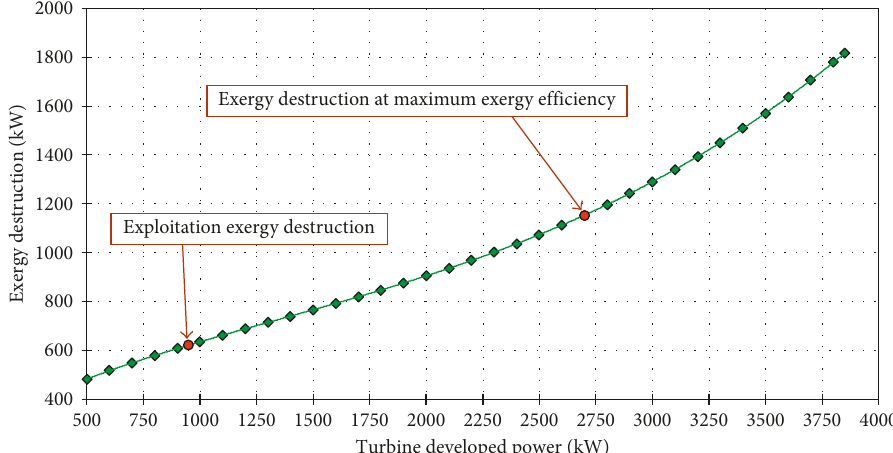
Figure 10: Steam turbine exergy destruction change during the developed power variation—operating point 8.